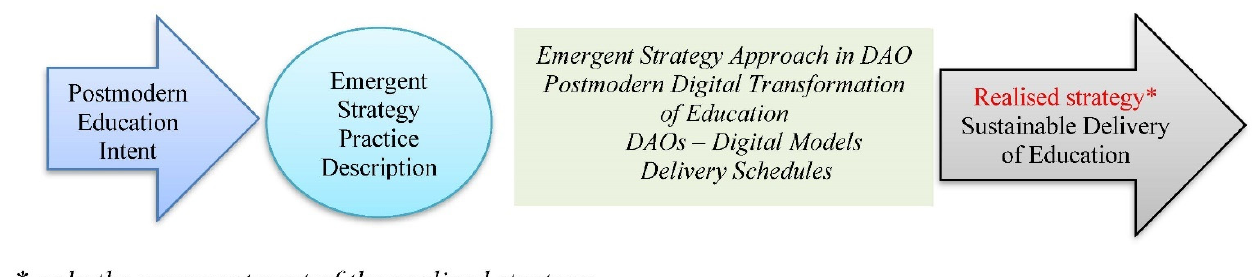
Figure 10. Emergent Strategy is Displayed as the Realised Strategy. Source: Based on (Foss et al. 2021).